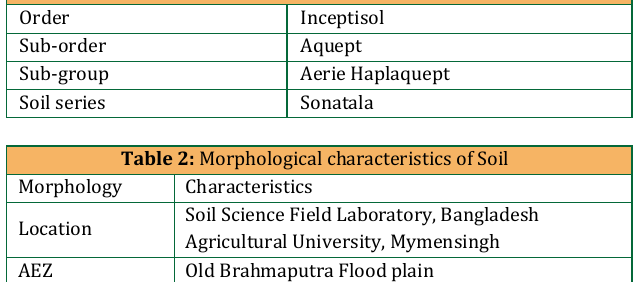
Table 1: Taxonomical characteristics of Soil